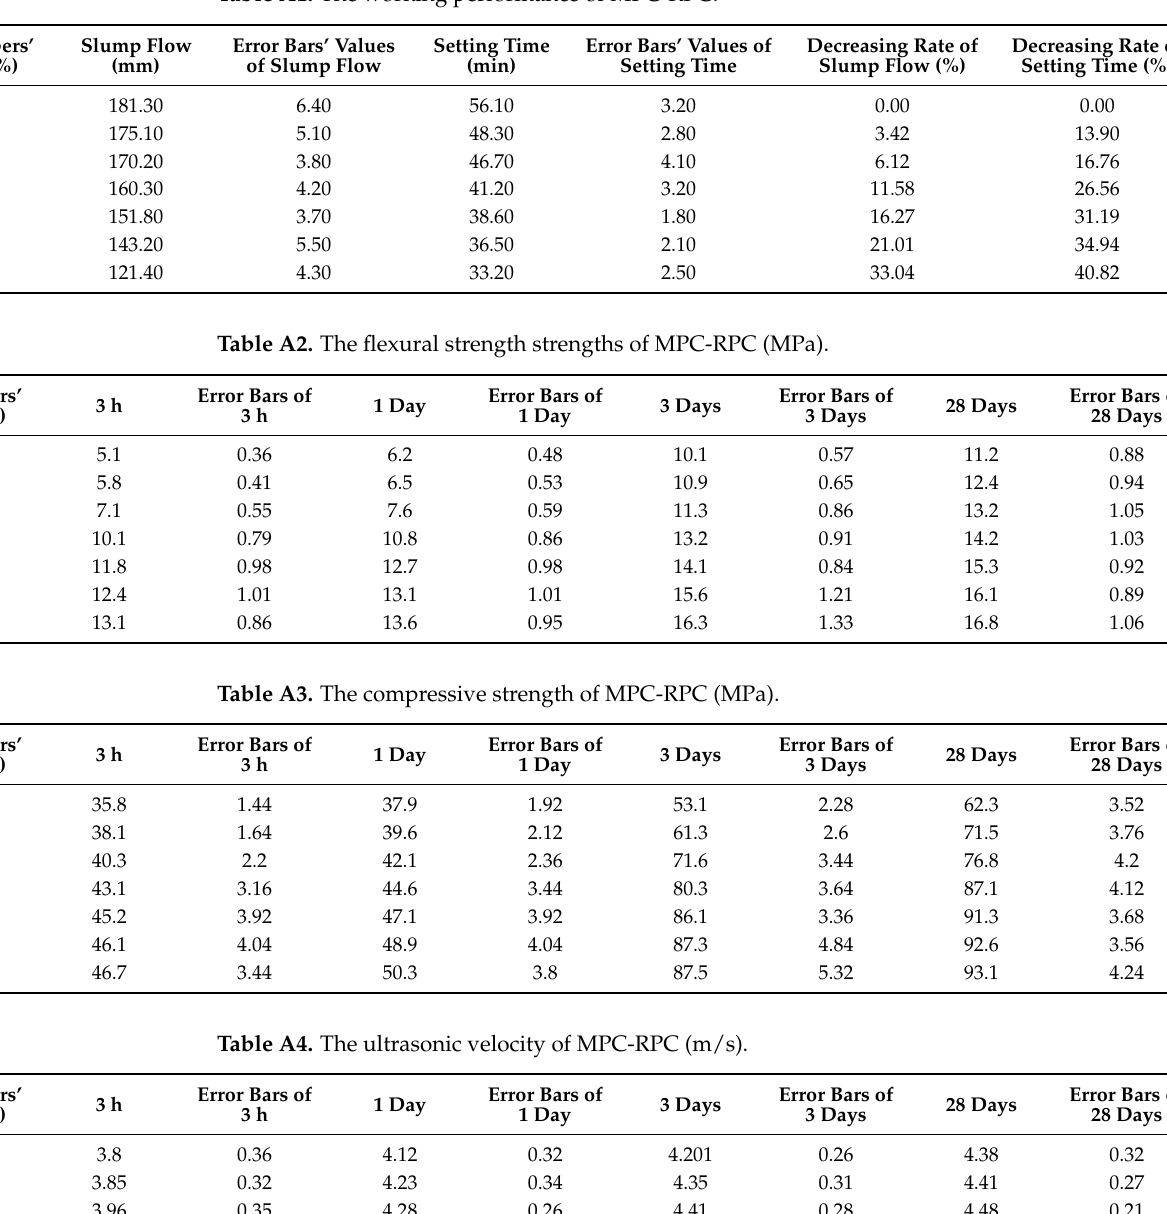
Table A1. The working performance of MPC-RPC.